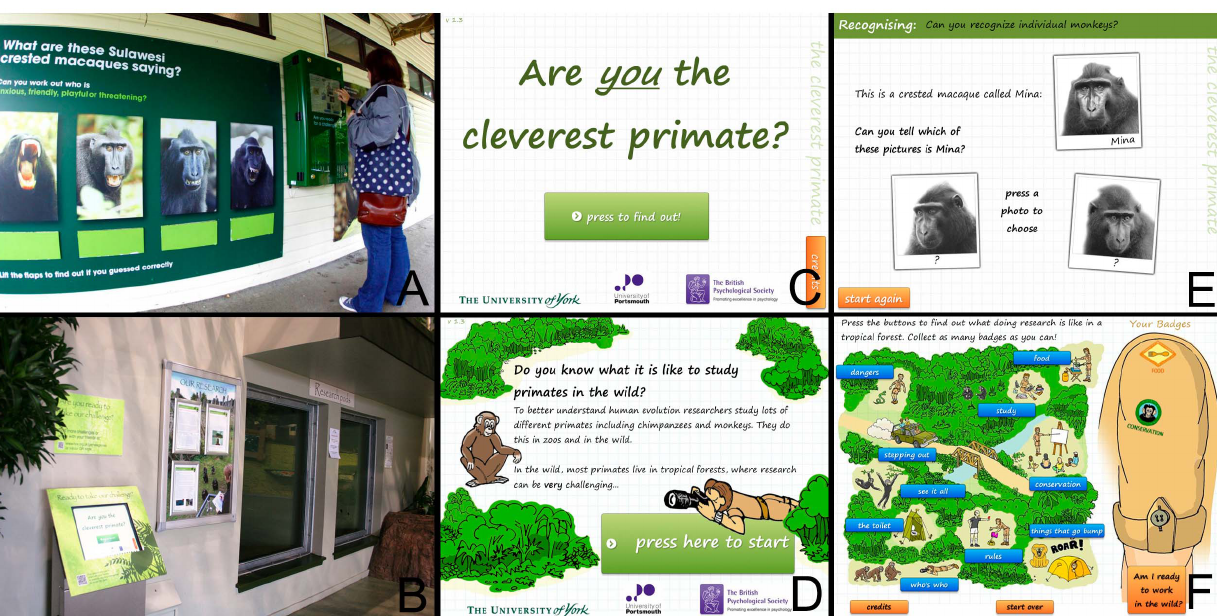
Figure 1. Example of educational games. A) Touchscreen at Marwell Wildlife. B) Touchscreen at Edinburgh Zoo. C) Opening screen of the ‘Cleverest Primate’ game. D) Opening screen of the ‘Research in the Wild’ game. E) Example of ‘Cleverest Primate’ gameplay. F) Example of ‘Research in the Wild’